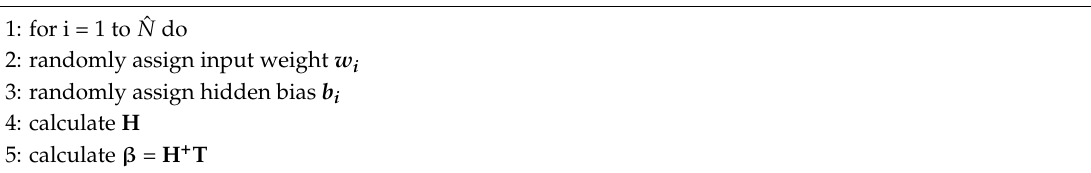
Algorithm 1. Algorithm for traditional extreme learning